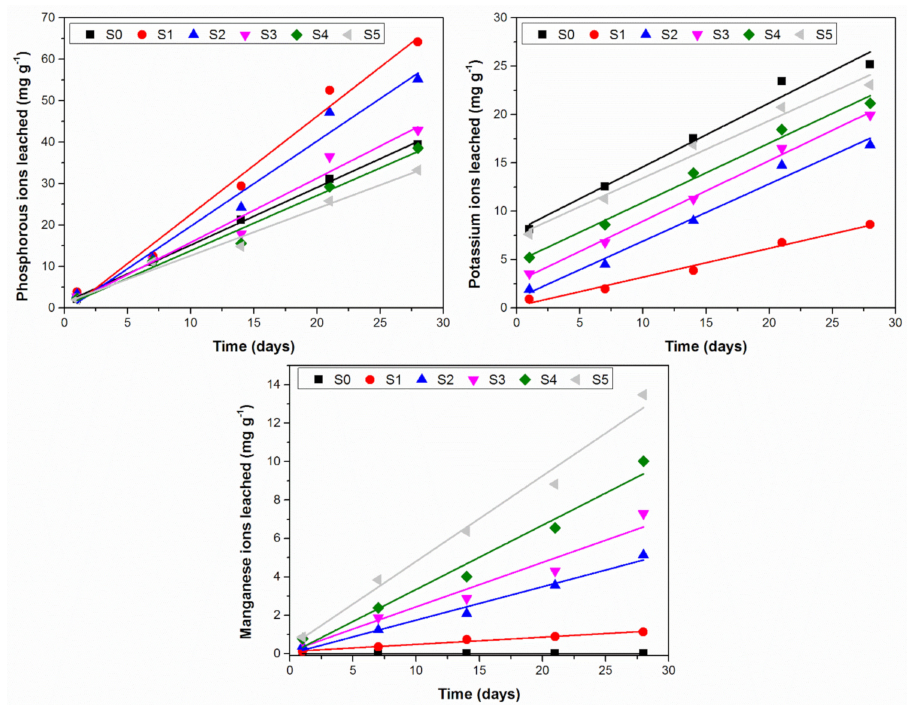
Figure 3. Ions dissolution from the studied glasses.